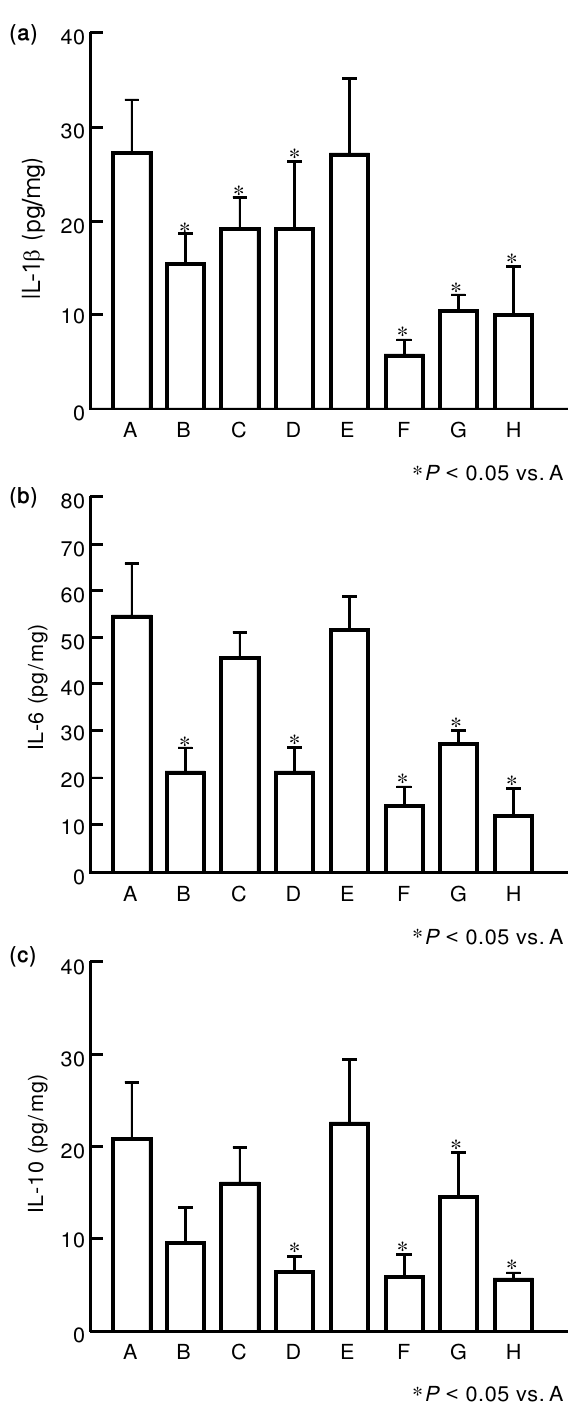
FIG. 1. Cytokine levels in colon mucosa in pg/mg tissue weight. A = saline; B = saline/DSS; C = SMS 36ug; D = SMS 36ug/DSS; E = SMS 120ug; F = SMS 120ug/DSS; G = OCT 3ug; H =